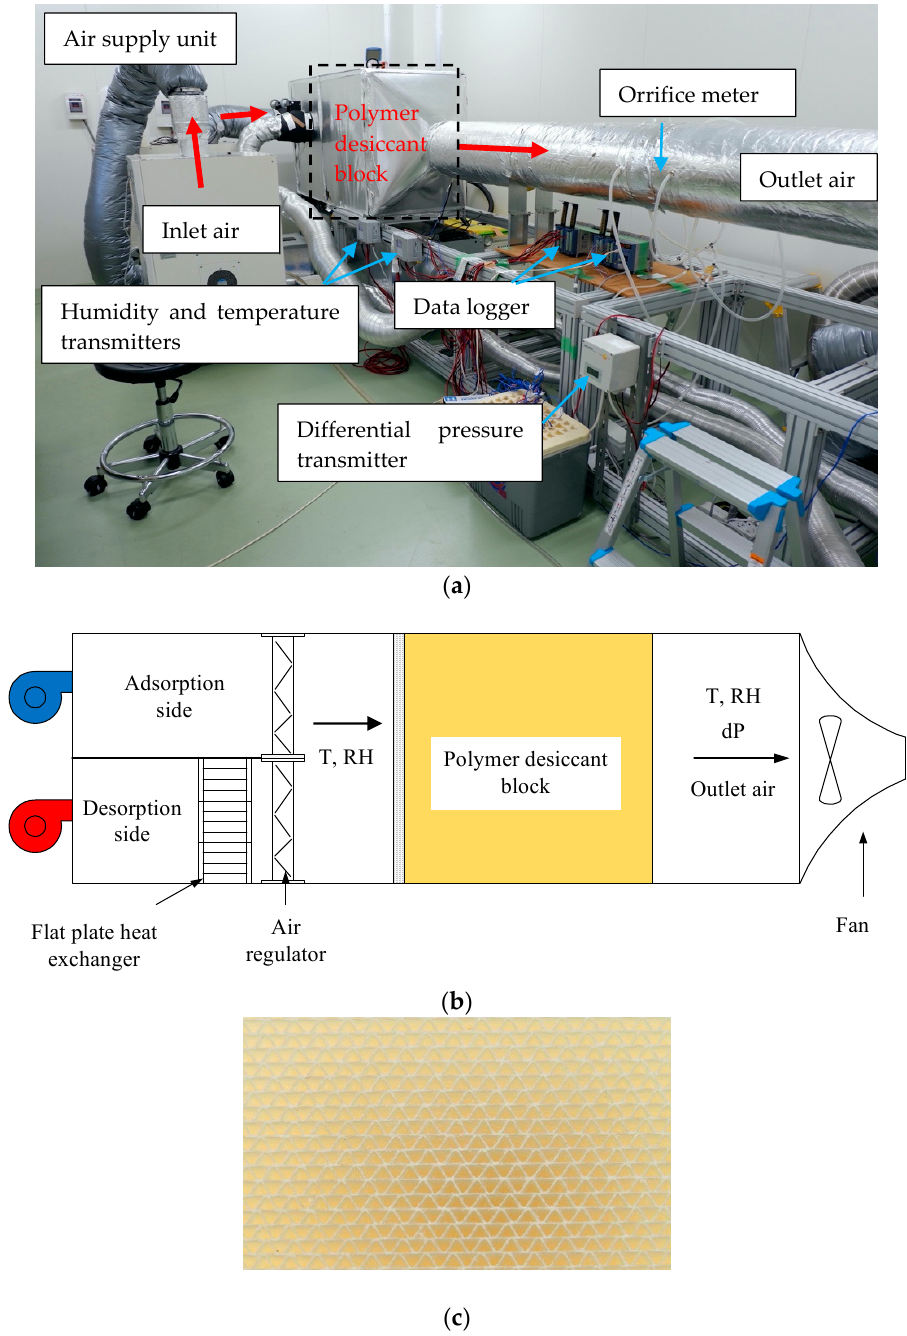
Figure 1. ( a ) The photograph [9]; ( b ) schematic diagram of the desiccant dehumidification system; ( c ) structure of the polymer desiccant block.